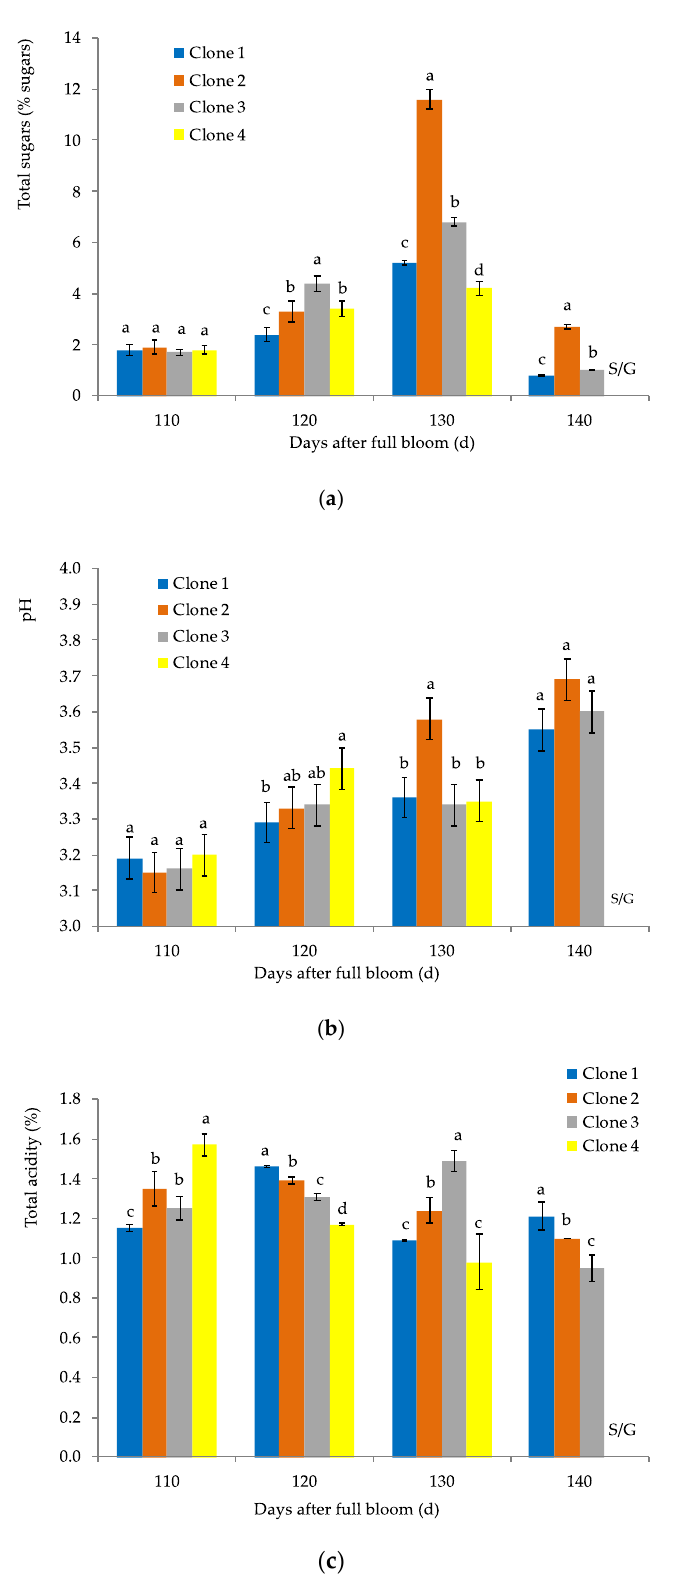
Figure 3. Fruit quality and weight parameters for four calafate clones according to different harvest dates: ( a ) fruit weight; ( b ) equatorial diameter; ( c ) soluble solids. Capital letters indicate significant differences between the different clones for the same harvest date, according to the Fischer test ( p < 0.05). Lowercase letters indicate significant differences in comparison between the different harvest dates for the same calafate clone, according to the Fischer test ( p < 0.05). S/G = no